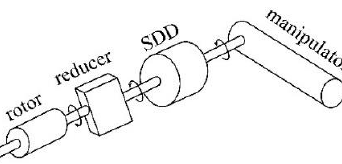
Figure 2. Connection mode of the SDD.